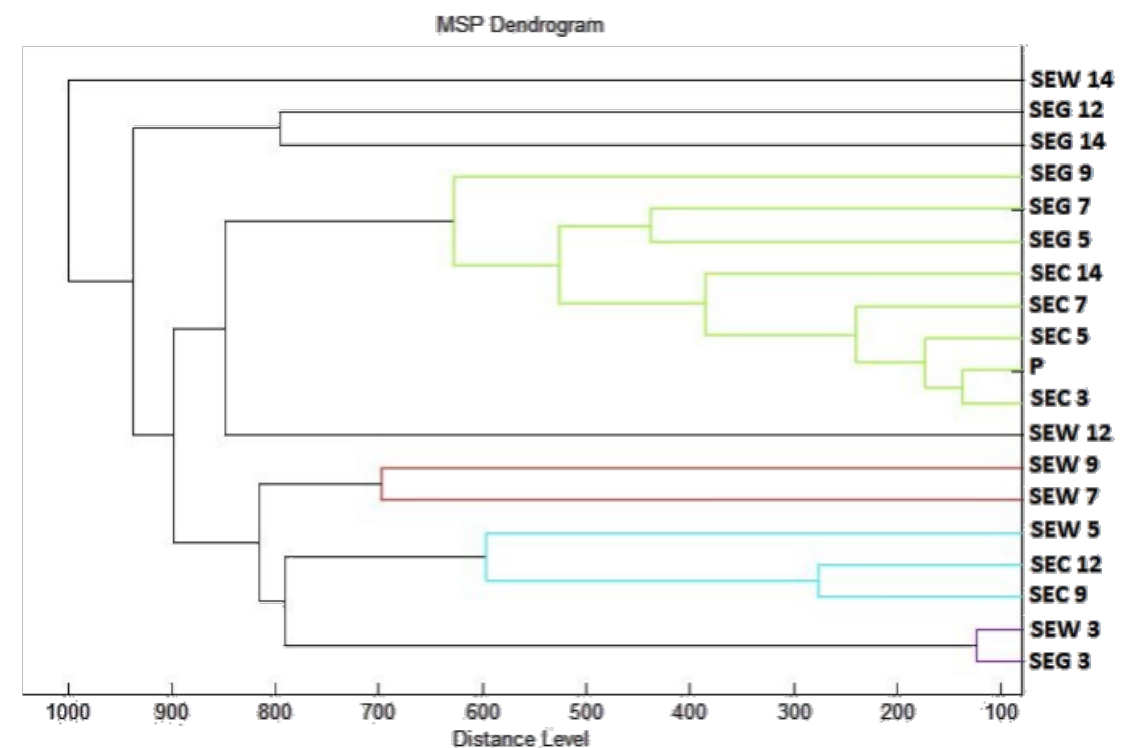
Figure 2. Dendrogram of S. enteritidis generated using MSPs of the planktonic cells and the control. SE, S. enteritidis ; C, control; G, glass; W, wood; and P, planktonic cells .